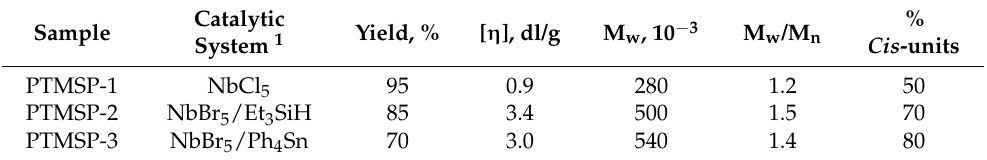
Table 2. Individual gas permeability coefficients of freshly prepared nonstabilized PTMSP films and